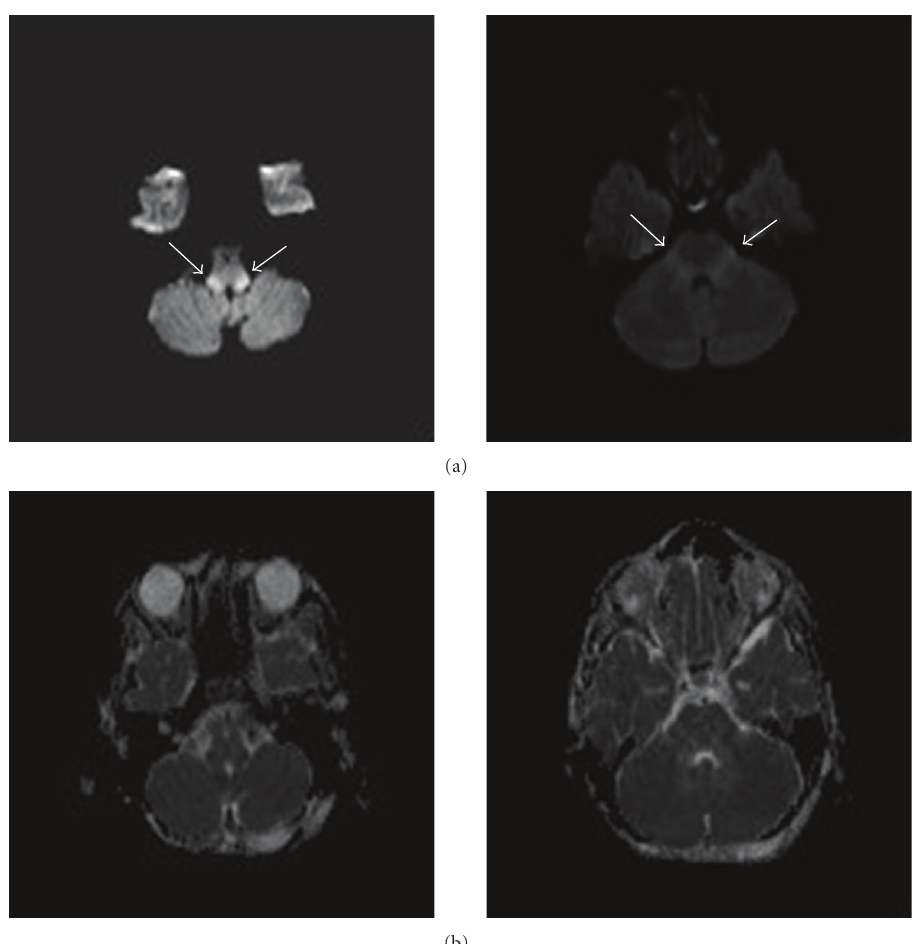
Figure 2: (a) Axial di ff usion-weighted MR images show marked hyperintensity in some areas of the inferior and middle cerebellar peduncles. (b) On the apparent di ff usion coe ffi cient (ADC) maps, they are distinctly